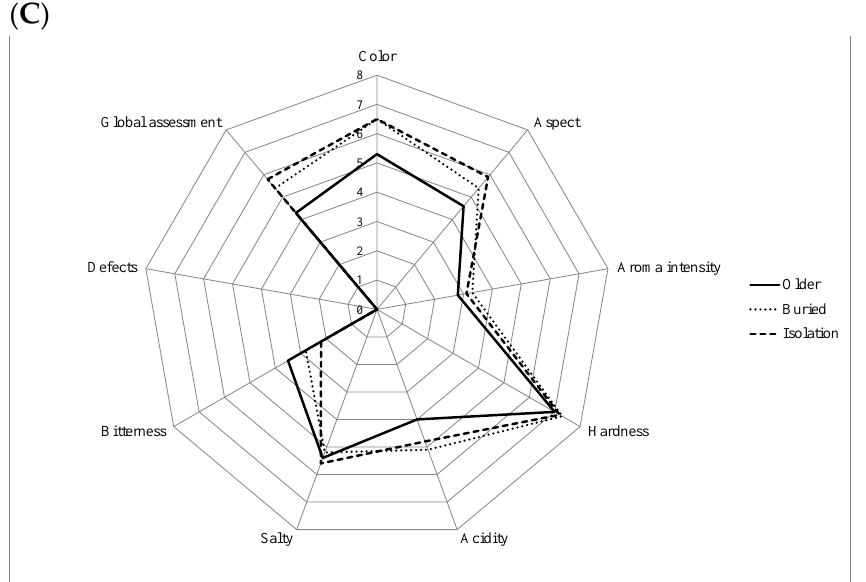
Figure 3. ( A ) Manzanilla Cacereña olive processed in control and sheltered fermenters (experiment 1); ( B ) Manzanilla de Sevilla submitted to different thermal treatments inside the fermenters and control treatment (experiment 2); ( C ) Manzanilla de Sevilla variety processed in older, buried, and isolated fermenters (experiment 3).